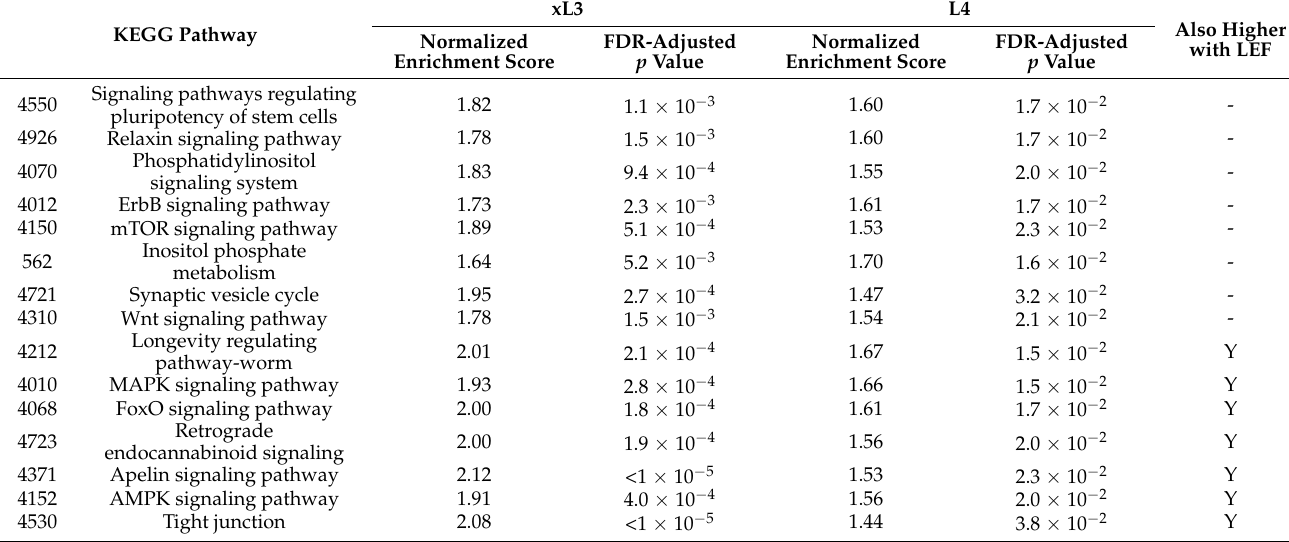
Table 3. Top 15 KEGG pathways most significantly upregulated in both xL3 and L4 H. contortus in response to Staurosporine